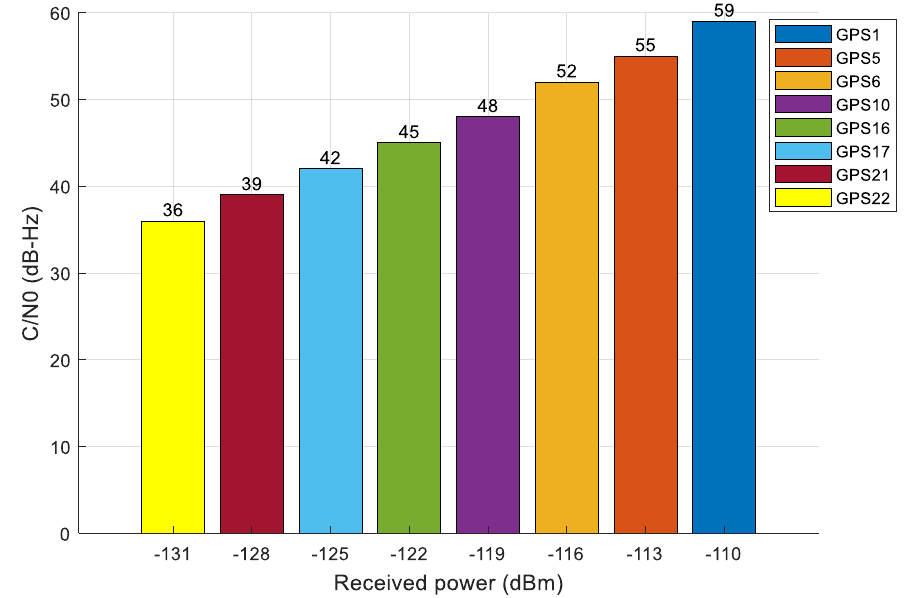
Figure 6. C/N 0 measurement of the GPS signals used for the calibration of the GoF method. Table 4. Estimated false alarm rate of each signal vs. each reference distribution. Table 5. GoF test method: assignment of the pre-computed GPS L1 C/A reference distribution functions to C/N 0 ranges of tracked signals.